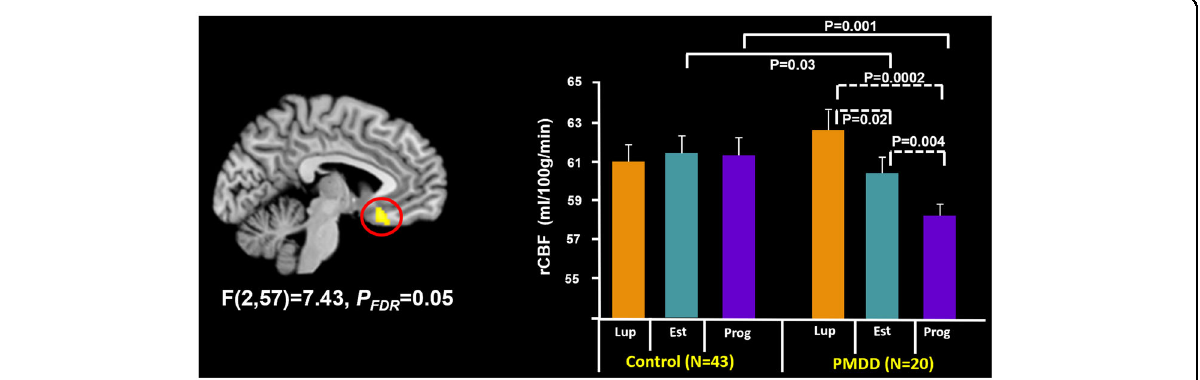
Fig. 2 Statistical parametric map showing a diagnosis-by-hormone interaction in the subgenual cingulate (SGCC) rCBF and post-hoc analyses. Left: Statistical parametric map showing voxels with a diagnosis-by-hormone interaction ( P FDR ≤ 0.05) in the subgenual cingulate (BA25, peak voxel MNI coordinates: − 6, 20, − 6). Right: Post-hoc analyses revealed that in healthy controls, there were no hormone-related rCBF differences in this region ( P ’ s ≥ 0.3). In contrast, in women with PMDD, we observed differences in rCBF across hormone states (all comparisons P ≤ 0.02), suggesting differential modulation of this region by ovarian steroids in PMDD. In addition, compared with controls, women with PMDD had similar levels of resting SGCC rCBF during Lupron alone (when PMDD symptoms remit) but had decreased rCBF during both estradiol ( P = 0.03) and progesterone ( P = 0.001) conditions (when symptoms are likely to recur). Solid line brackets show comparisons between diagnosis and dashed line brackets show comparisons across hormone conditions in women with PMDD. Est estradiol, Lup lupron, Prog progesterone.